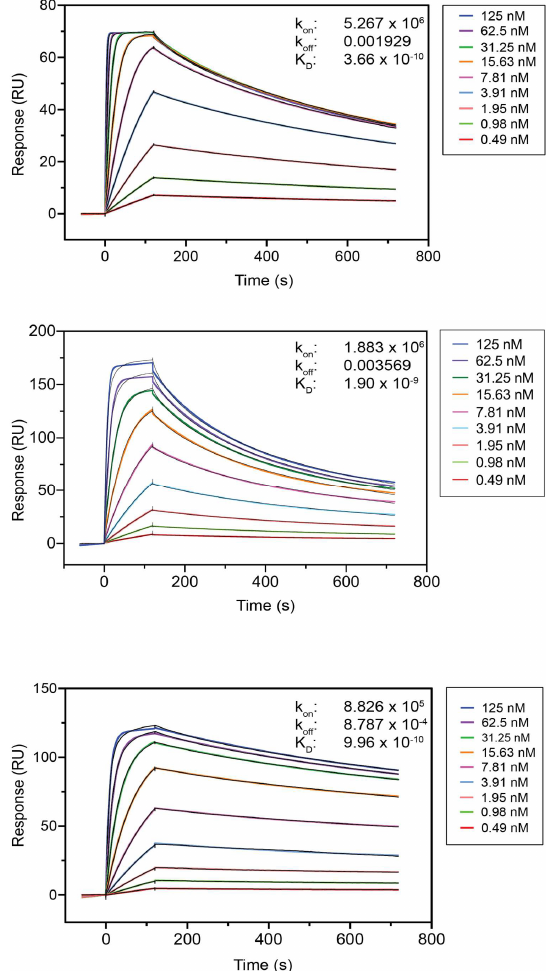
Figure 2. Antigen-binding affinity of Nbs HE4-1 ( top ), SLPI-7 ( middle ), and PGRN-7 ( bottom ), as determined by SPR (k on in M −1 .s −1 and k off in s −1 ).